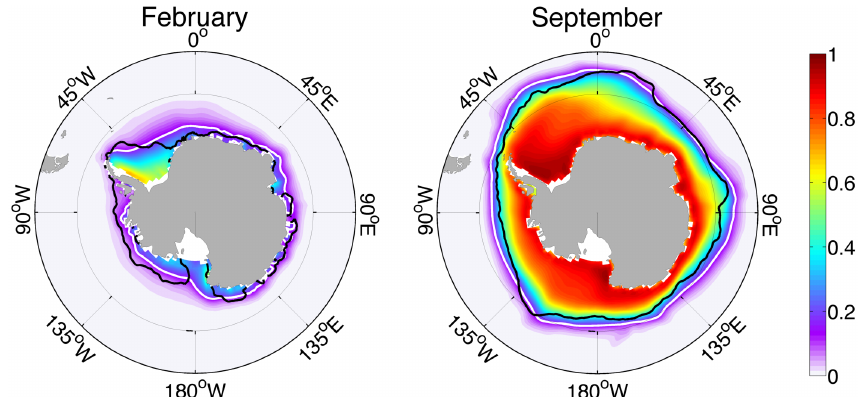
Fig. 1. Multi-model mean of sea ice concentration, computed from historical simulations over the period 1979–2005. White (black) line refers to the sea ice edge, i.e. the 15% concentration limit of the multi-model ensemble mean (observations, Comiso, 1999, updated 2008).